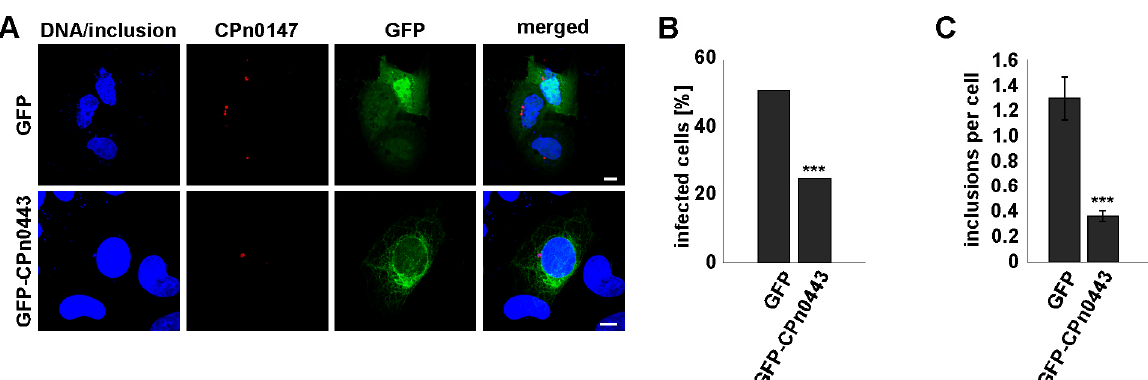
Figure 8. Ectopically expressed CPn0443 resulted in reduced Cpn infection. ( A ) Confocal fluorescence images of GFP or GFP-CPn0443-expressing (green) U2OS cells followed by Cpn infection (MOI 1) for 30 h. The chlamydial inclusion membrane was visualized with the anti-CPn0147 antibody (red) and DNA/inclusions with DAPI (blue). Scale bars: 5 µ m. ( B , C ) Quantification of the number of infected cells ( B ) and chlamydial inclusions ( C ) per cell. U2OS cells transfected with GFP or GFP-CPn0443 and infected with EBs were analyzed. Error bars denote ± SEM. Two-tailed unpaired Student’s t -test; p < 0.001 (***). n = 2; 50 cells per experiment and plasmid.